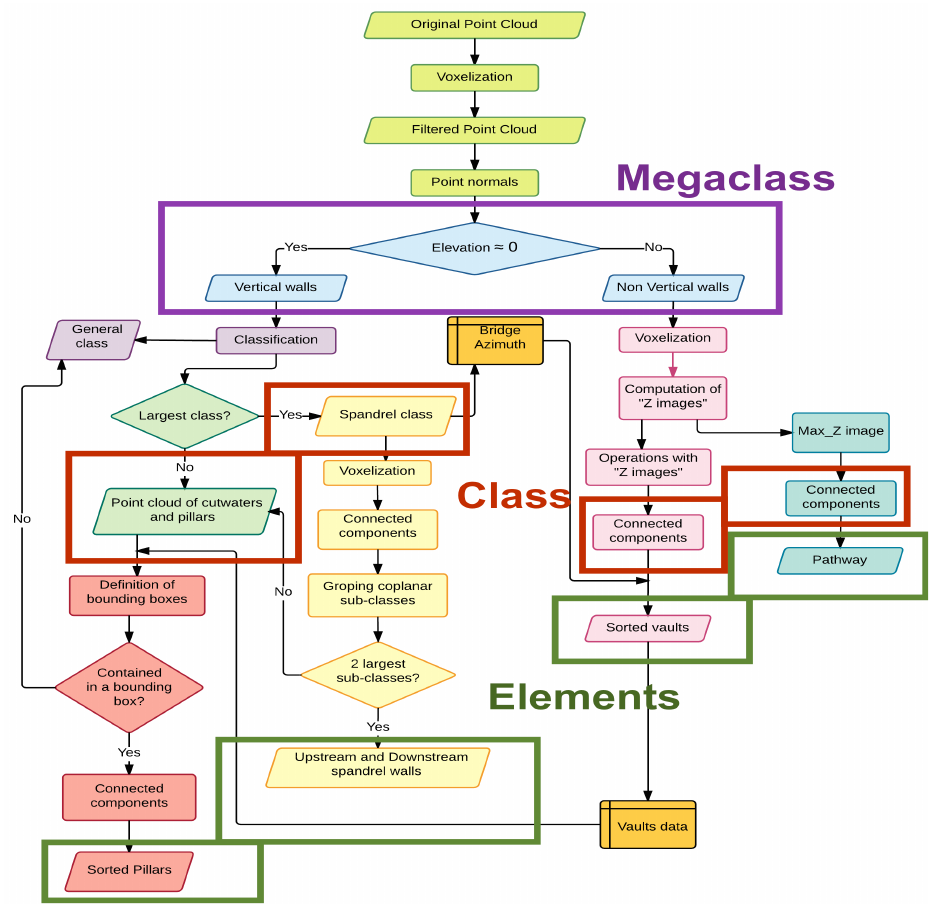
! Figure 1. UML diagram of the proposed method for the segmentation of masonry arch bridges point